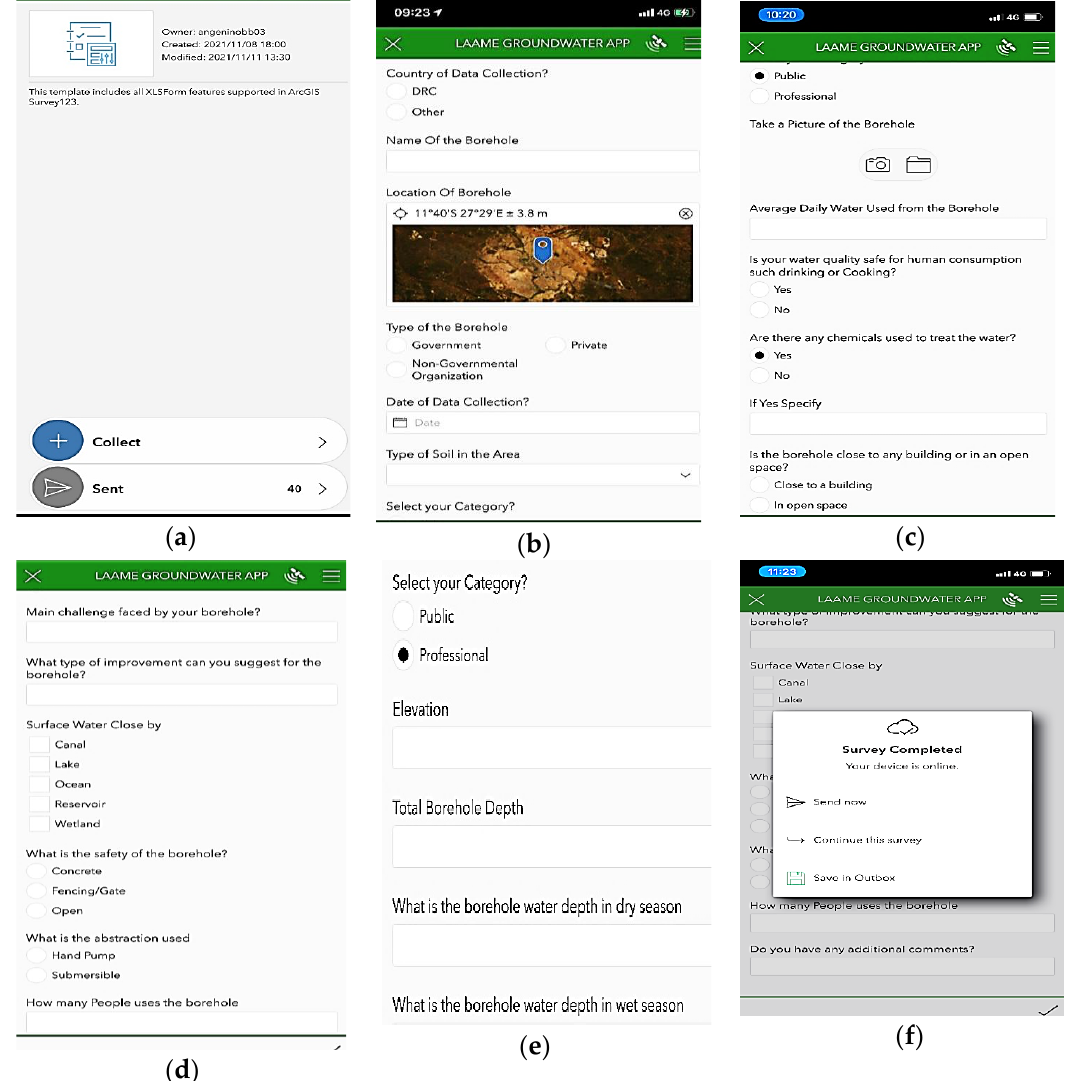
Figure 24. ( a – f ) Running procedure of the developed app on a mobile phone (Source: Authors).